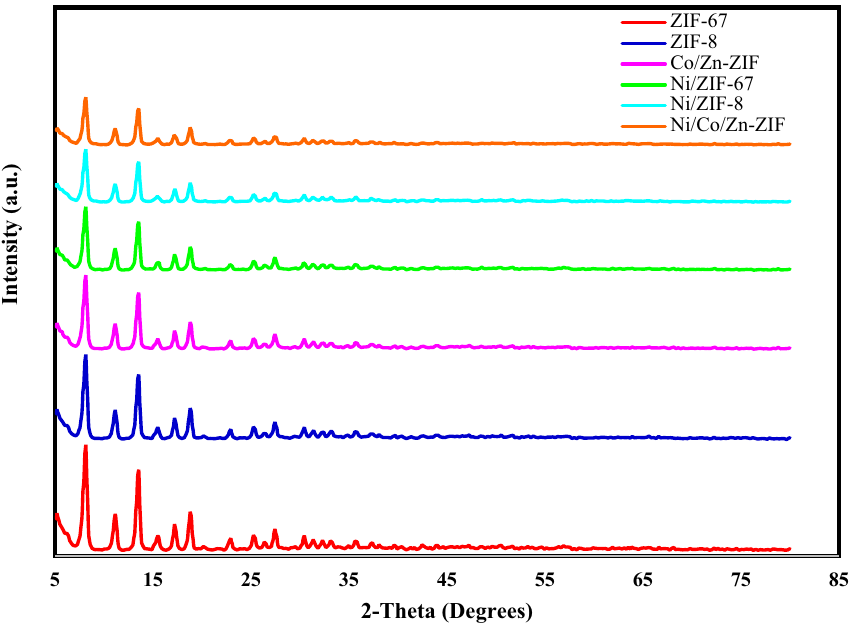
Figure 3. Powder XRD patterns of ZIF-67, ZIF-8, CoZn-ZIF, NiCo-ZIF, NiZn-ZIF and NiCoZn-ZIF.